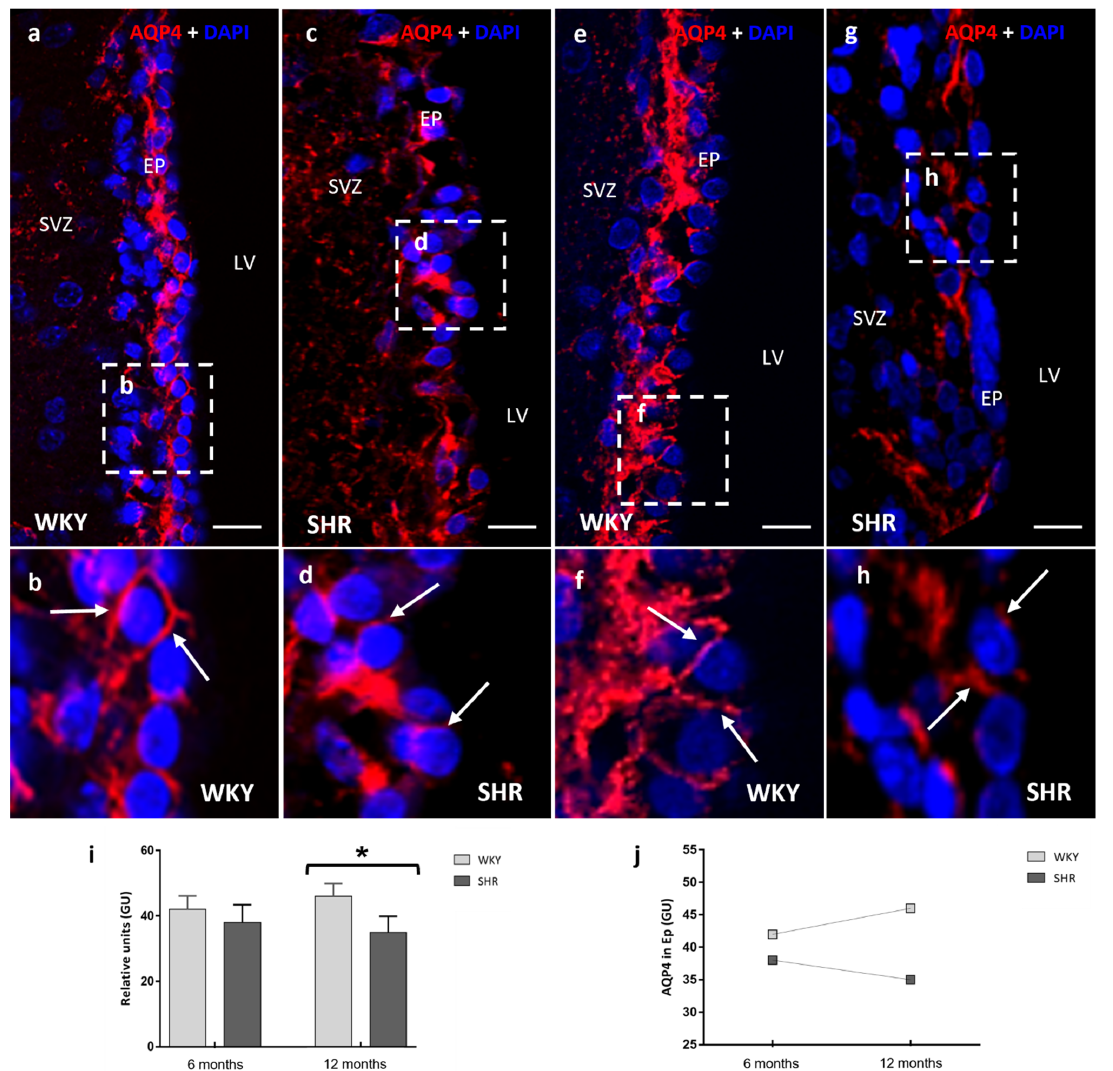
2.2. AQP4 in Ependymal Cells and Subependymal Astrocytes (Brain–CSF Interface) Ependymal cells are known to display the AQP4 water channel in the basolateral membrane domain. As expected, AQP4 was localized in the ependymal cells and the feet of astrocytes overlying the ependyma (Figure 2). The study was performed in the lateral wall of the lateral cerebral ventricle. AQP4 immunofluorescence showed no significant differences between both 6 months groups (WKY 42 ± 4.3 vs. SHR 38 ± 4.8 relative units) (Figure 2 a,b,c,d), whereas significant differences ( p < 0.05) (Figure 2e) were found be ‐ tween WKY ‐ 12 months (46 ± 3.6 relative units) and SHR ‐ 12 months (35 ± 4.4 relative units) in AQP4 expression (Figure 2e,f,g,h). Between 6–12 months, AQP4 increased in the epen ‐ dyma of WKY rats, while the opposite was exhibited in SHR. Thus, chronic hypertension decreases AQP4 in the ependyma, which is different from what is observed in the control group, where it increases progressively (Figure 2f).